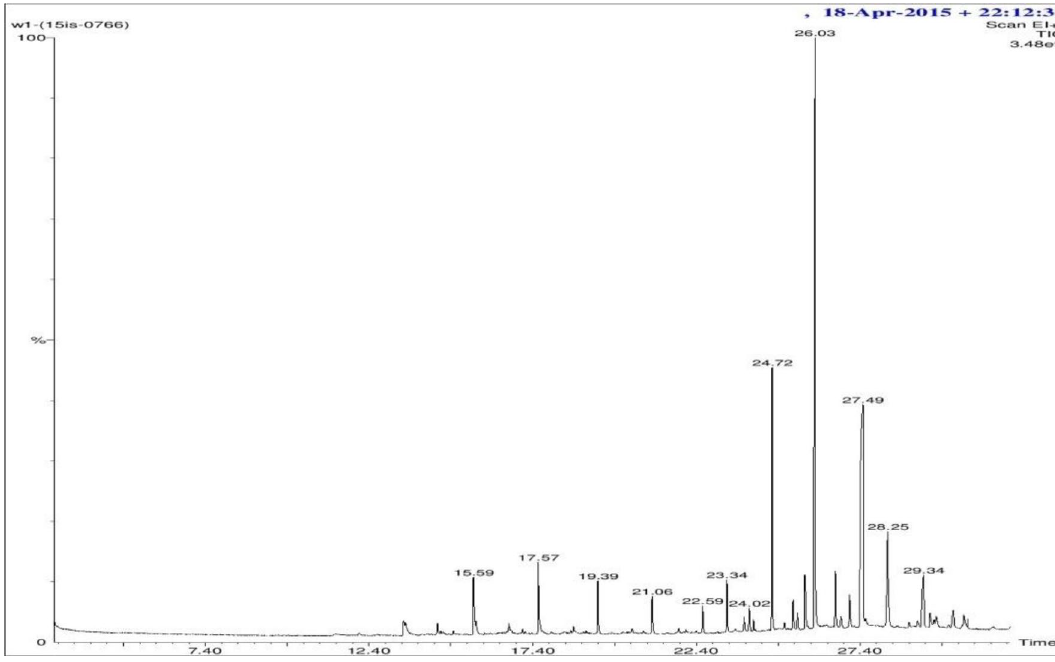
Fig. 3 GCMS chromatogram of F3